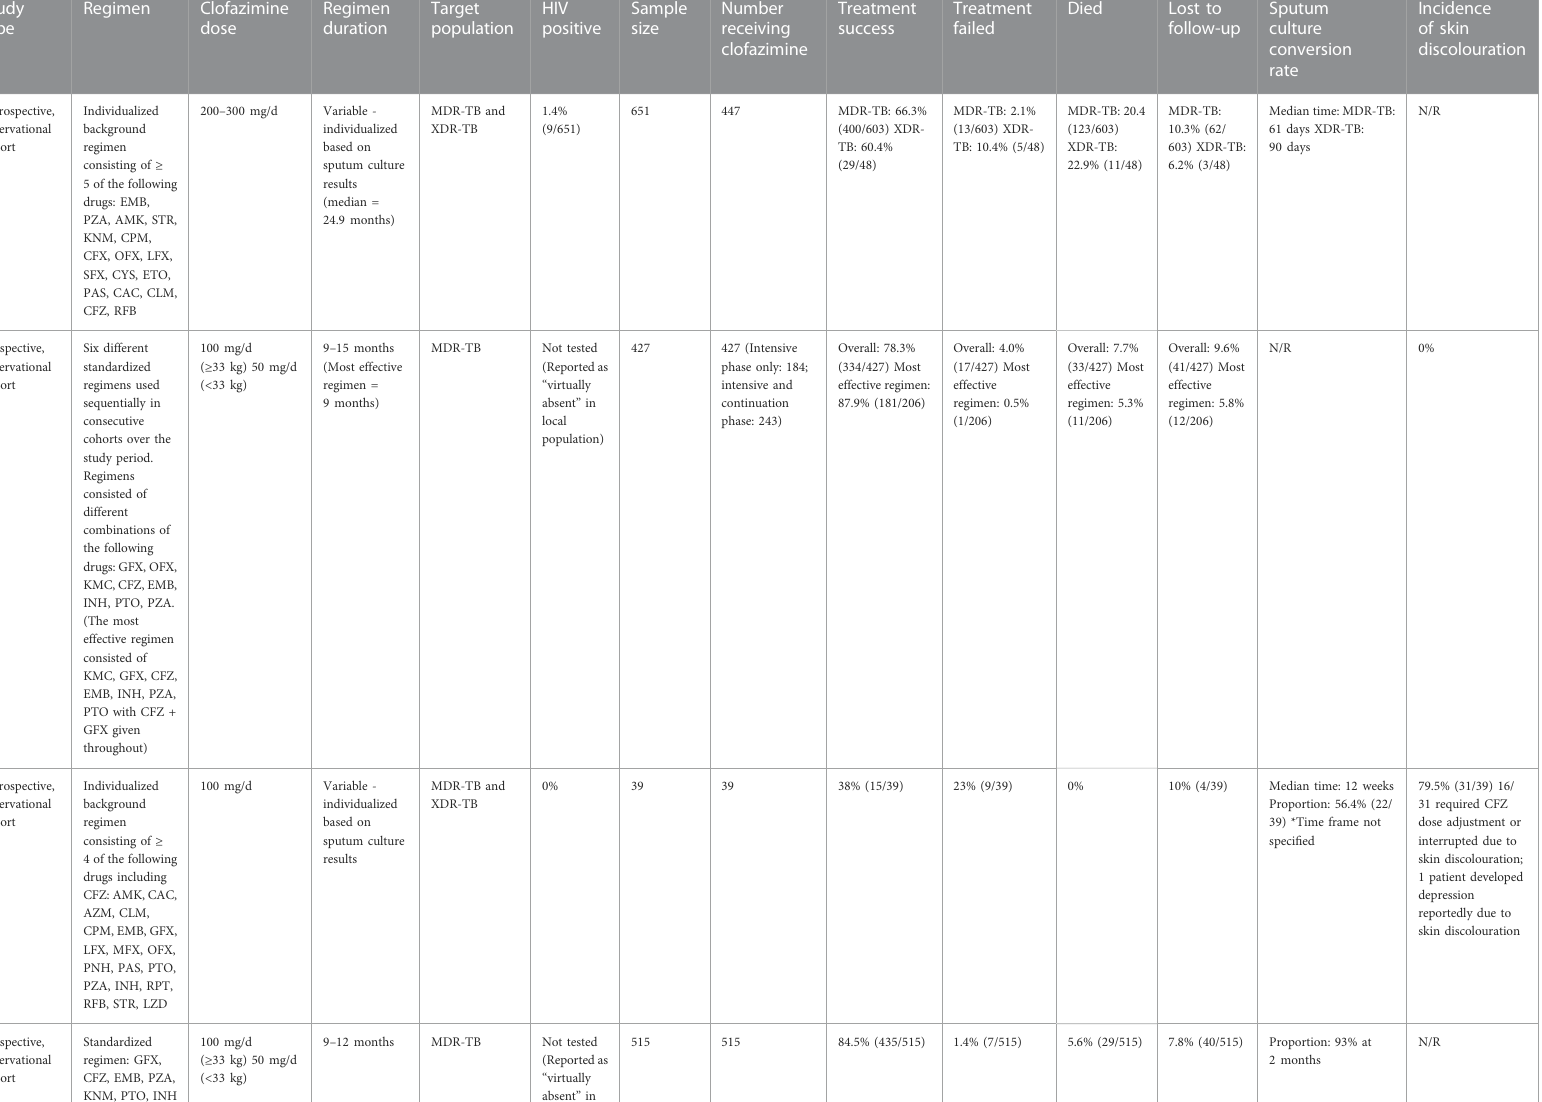
TABLE 1 Clinical studies reporting ef fi cacy and safety outcomes with regimens containing clofazimine (without* bedaquiline and linezolid) in adult patients with drug-resistant tuberculosis. Study